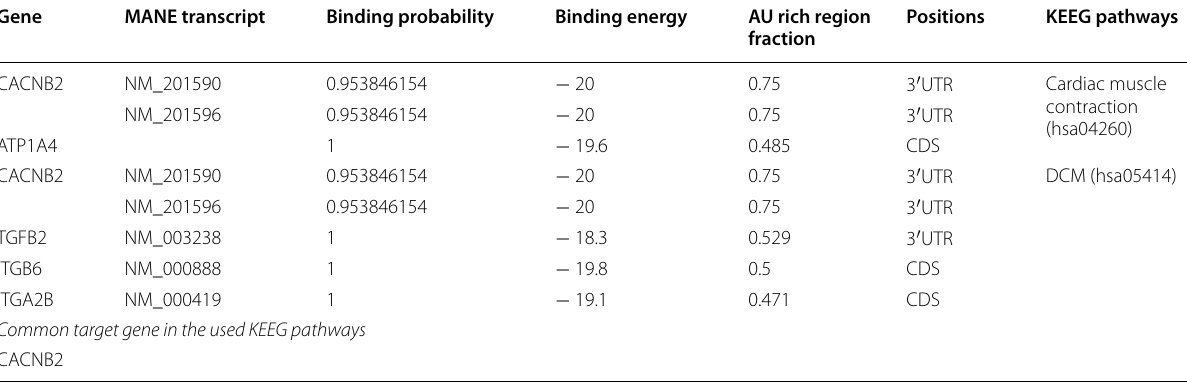
Table 3 Predicted targeted genes for miR‑454‑3p (based on MANE transcript)